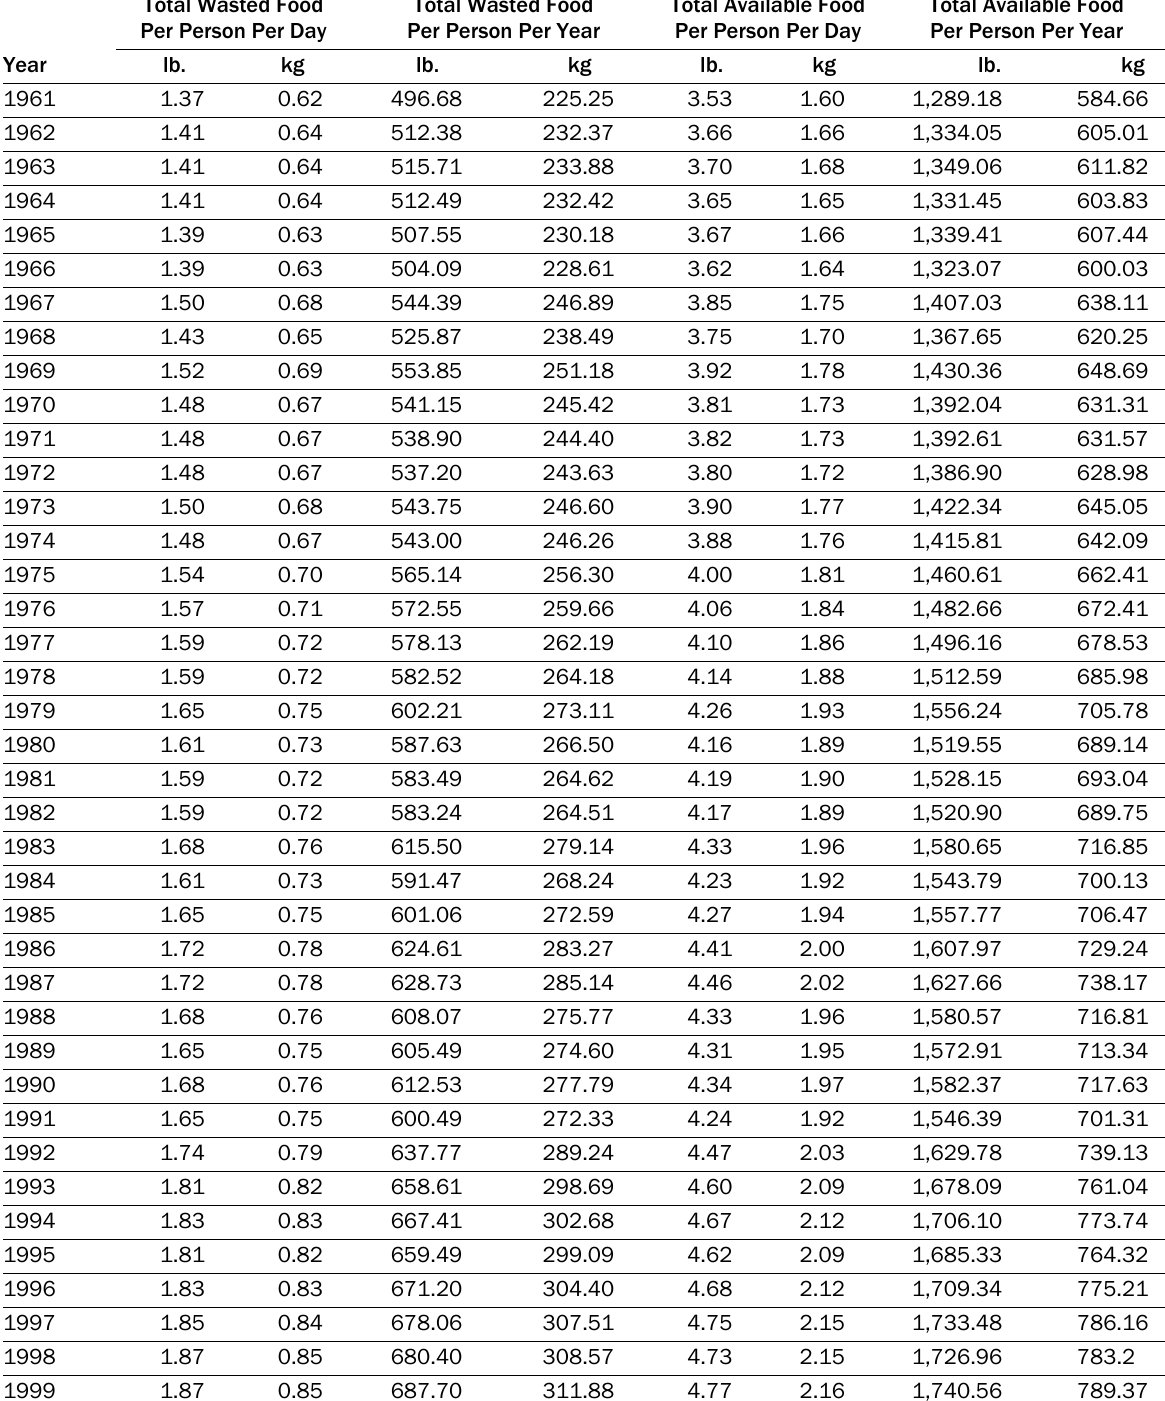
Table 3. Total Food Waste and Food Consumption per Person per Day and per Year, Canada,